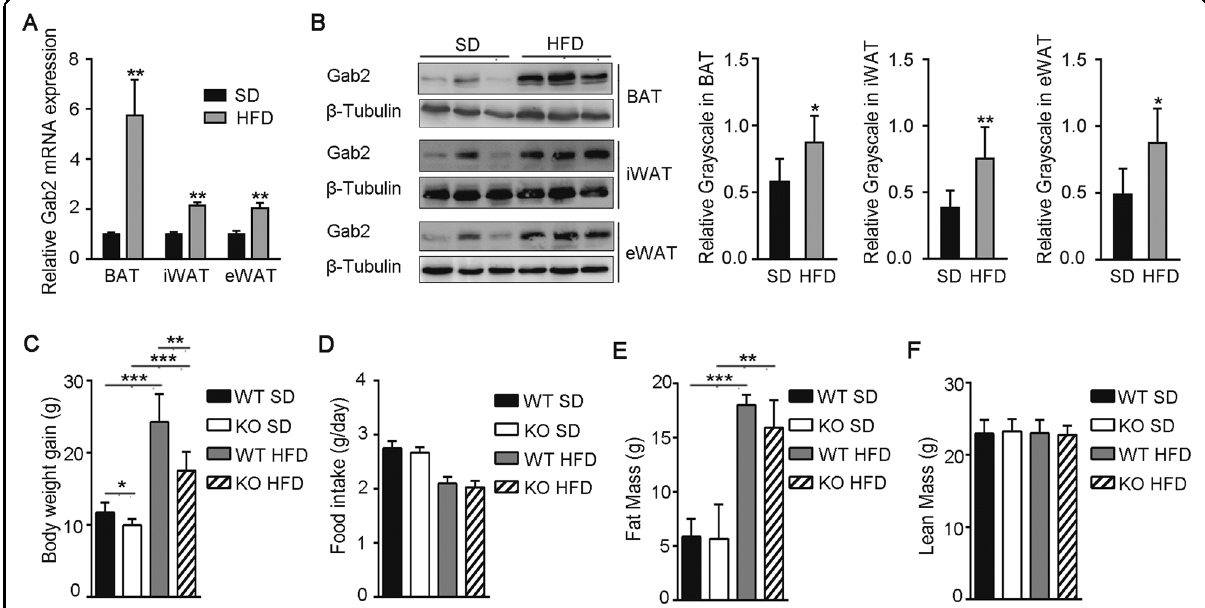
Fig. 1 Gab2 is increased in adipose tissue in HFD-fed mice and deletion of Gab2 protects against HFD-induced obesity. A Relative mRNA level of Gab2 in brown adipose tissue (BAT), inguinal (iWAT), and epididymal (eWAT) white adipose tissue from mice fed with a standard diet (SD) or a high-fat diet (HFD) for 12 weeks detected by RT-qPCR. The results were normalized with S18 mRNA levels. B Left panel: representative blots of Gab2 protein expression in BAT (top), iWAT (middle), and eWAT (bottom) of mice described in A detected by immunoblotting analysis; Right panel: the relative grayscale values of Gab2 protein blots, β -Tubulin protein was measured as a loading control. C – F Bodyweight gain from weeks 6 to 18 ( C ), food intake ( D ), fat mass ( E ), and lean mass ( F ) of Gab2 KO and WT mice fed with SD and HFD diet for 12 weeks. The data are presented as mean ± SD from at least six mice in each group. Statistical difference is indicated: * P < 0.05; ** P < 0.01; *** P <